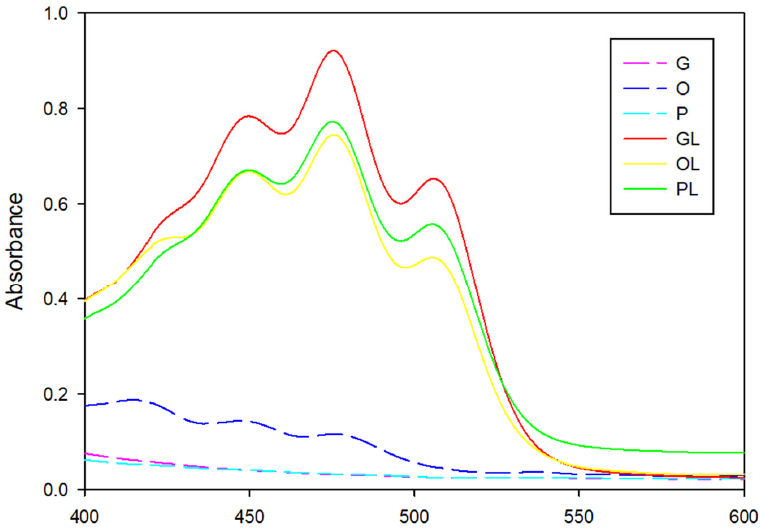
Figure 10. UV-Vis spectroscopy of native oils (G, O, P) and oils with lycopene (GL, OL, Figure 10. UV ‐ Vis spectroscopy of native oils (G, O, P) and oils with lycopene (GL, OL, PL).